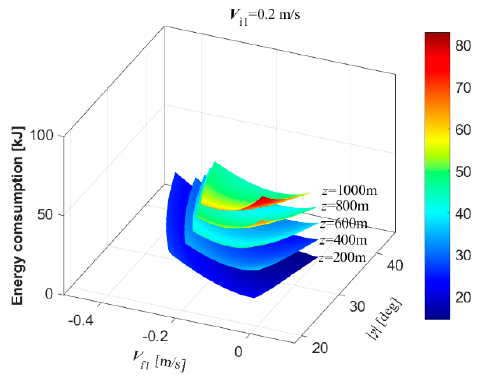
Figure 9. The energy consumption with different V f1 , | γ | and z , when V i1 = 0.2